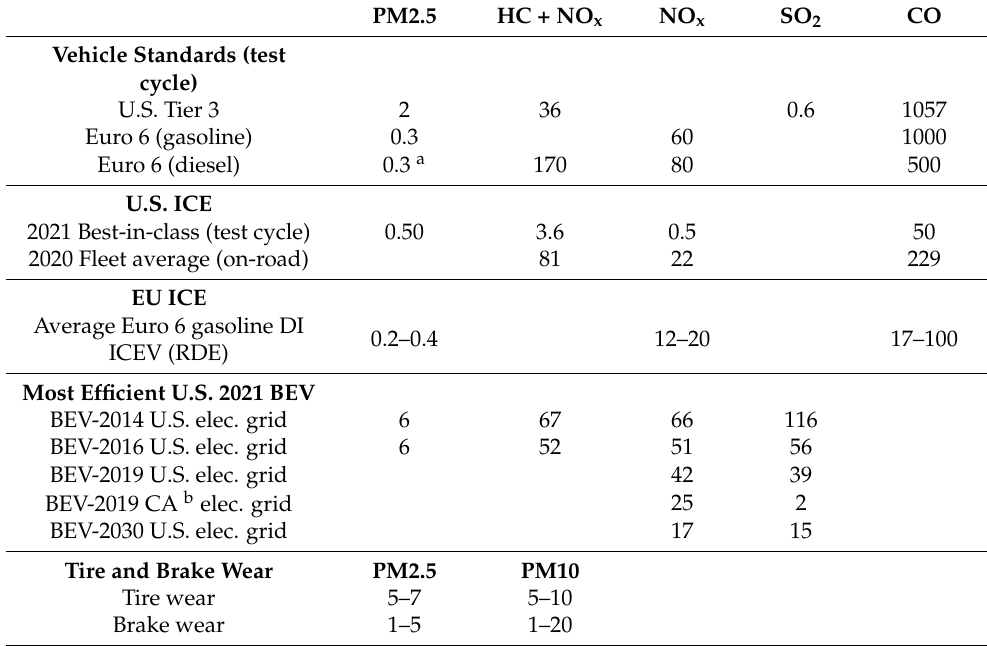
Table 1. Comparison of U.S. and EU vehicle emission standards (mg/km) with emissions from selected gasoline light-duty ICE vehicles and BEVs, and non-exhaust brake wear and tire wear emissions (updated from Winkler et al. [46] and Wallington et al. [45]). PM2.5 HC + NO x NO x SO 2 CO Vehicle Standards